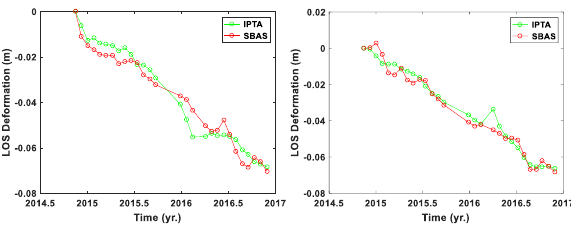
Figure 9. Deformation time series corresponding to points 3 and 4 obtained from both IPTA and SBAS.